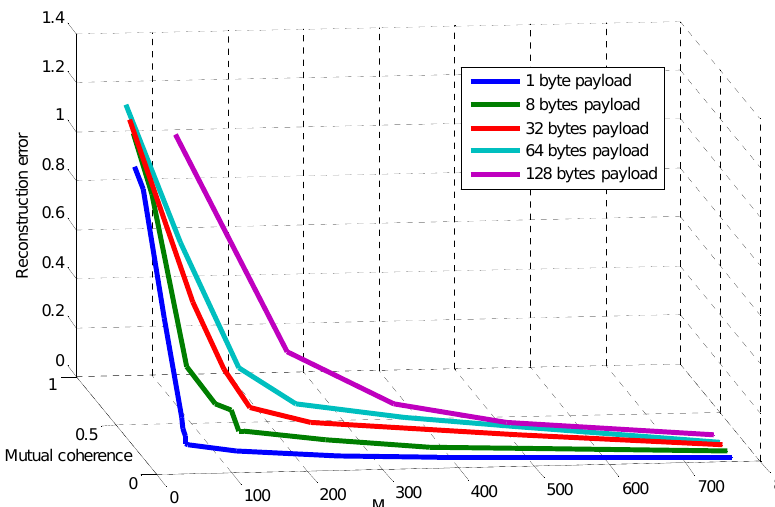
Figure 8. Relationship between measurement number, mutual coherence and reconstruction